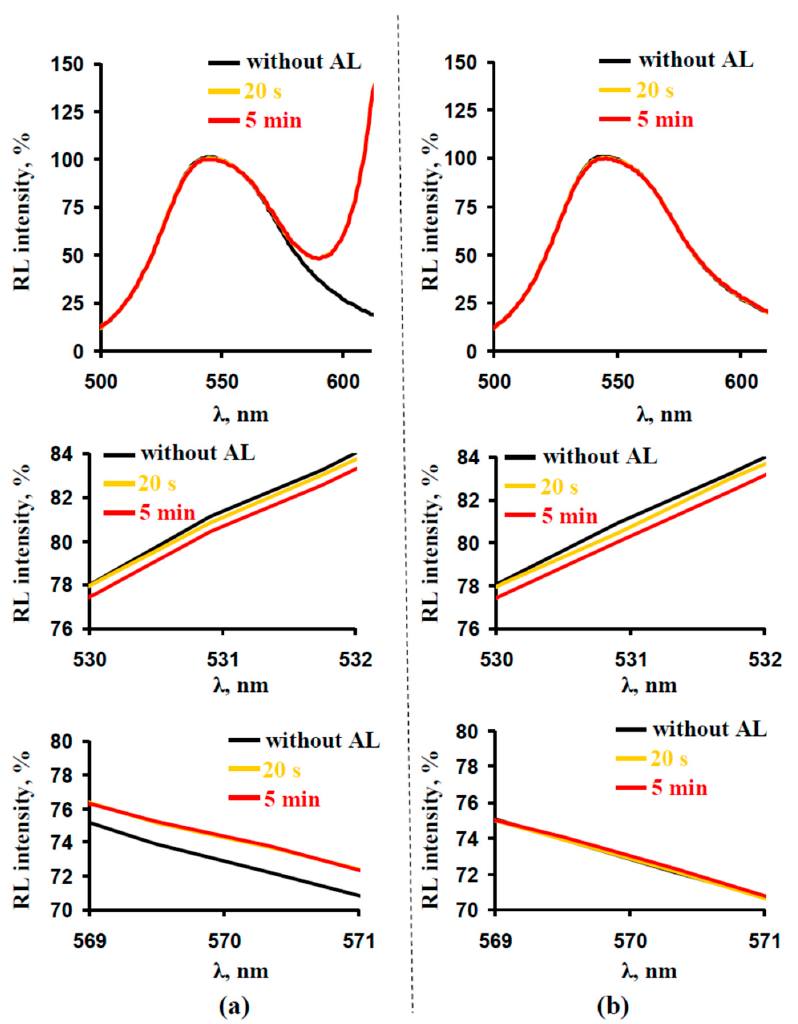
Figure 3. The spectrum of intensity of the RL during the GYL pulse ( a ), and difference between the RL spectrum during the GYL pulse and this spectrum before the pulse ( b ) in pea ( n = 6). The spectrum was measured before illumination by the AL (maximum intensity at 630 nm, 1599 µ mol m − 2 s − 1 ) (“without AL”), after 20 s of illumination by the AL (“20 s”), and after 5 min of illumination by the AL (“5 min”). The upper panels show the spectrum from 500–610 nm, the medium panels show part of the spectrum from 530–532 nm, and the lower panels show part of spectrum from 569–571 nm. The maximum absolute intensity of RL at 550 nm was assumed to be 100%.